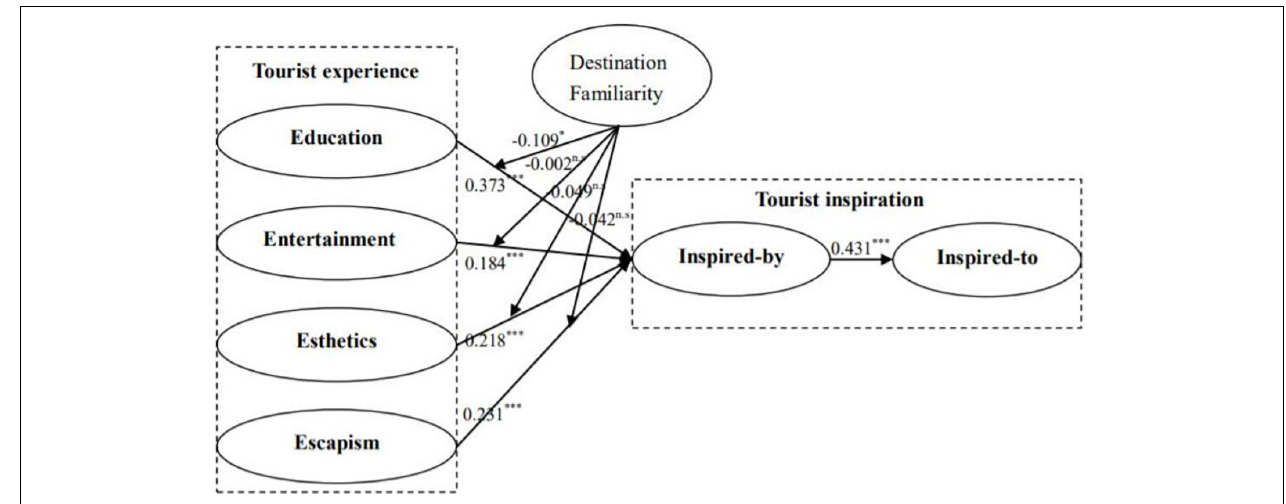
FIGURE 2 | Path co-efficient model. ∗ P < 0.05, ∗∗ P < 0.01, ∗∗∗ P < 0.001, n . s P >